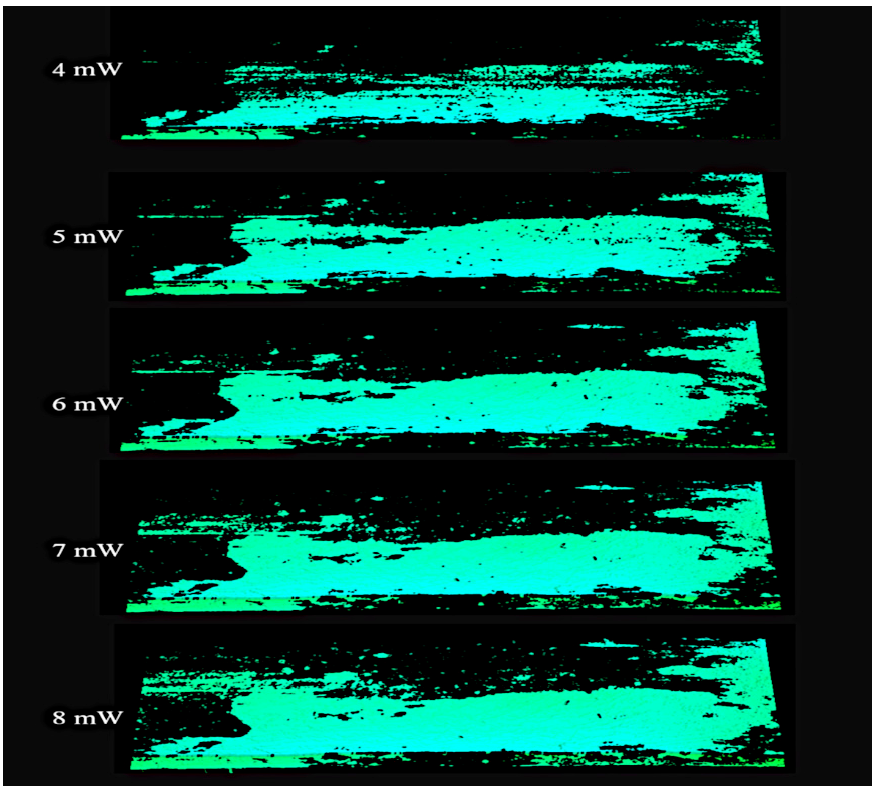
Figure 9. Image of a non ‐ infected region area on the board surface recorded with a laser operating at a power range of 4 to 8 mW.